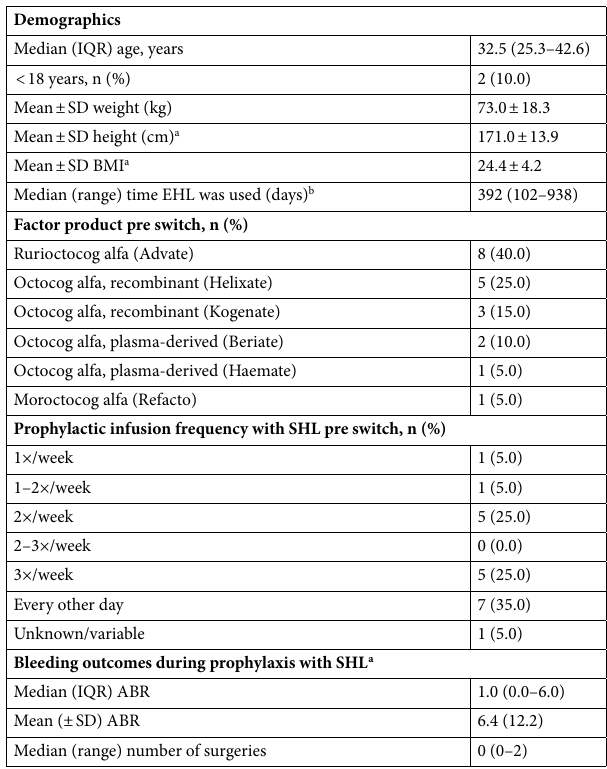
Table 1. Description of the study cohort and pre switch (i.e. 6-month period of SHL prophylaxis before switch to EHL) data (n = 20). Description of the study cohort including demographics, factor products and infusion frequency pre switch (during prophylaxis with SHL). a Here, n = 19, as values were not recorded, and therefore not available for one subject. b Here, n = 18, as values were not recorded, and therefore not available for two